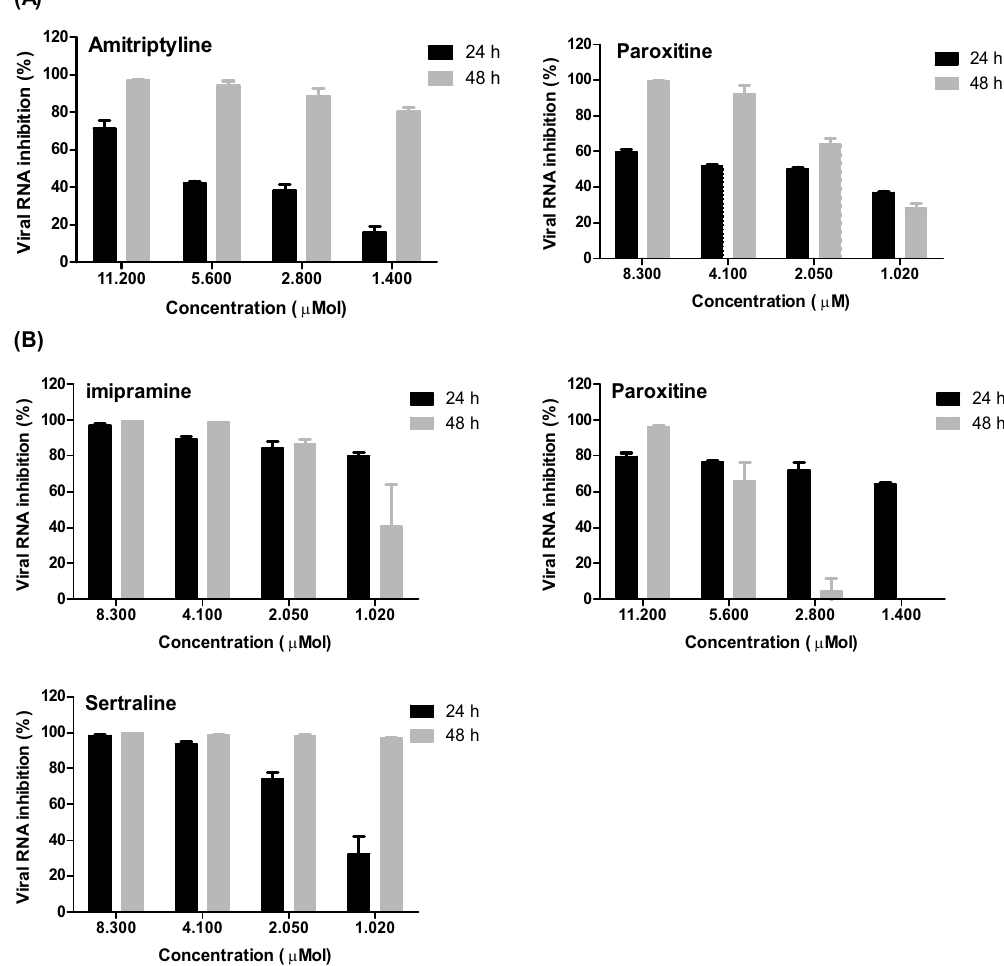
Figure 3. Impact of tested antidepressants on viral RNA copy numbers in infected Vero E6 cells (MOI 0.05) at 24 and 48 h post-treatment. Cells were infected with SARS-CoV-2 ( A ) and MERS-CoV ( B ) and then treated with various concentrations of the tested